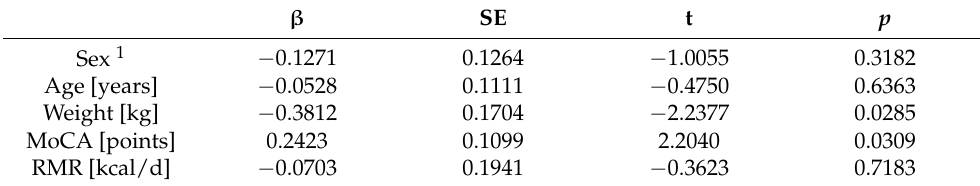
Table 11. Multivariate linear regression analysis assessing the relationship between total physi- cal activity [counts/minute] measured by the ActiGraph and selected variables in the total study population ( n =